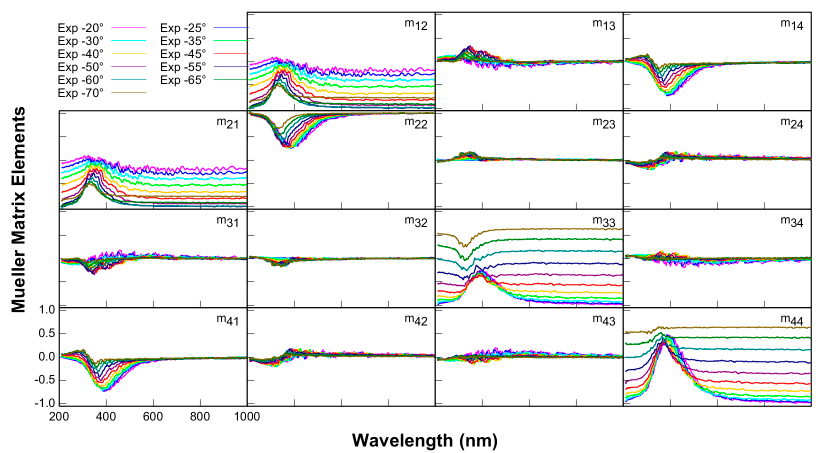
Figure A1. Mueller ‐ matrix spectra at several angles of incidence measured in reflection mode. Figure A1. Mueller-matrix spectra at several angles of incidence measured in reflection